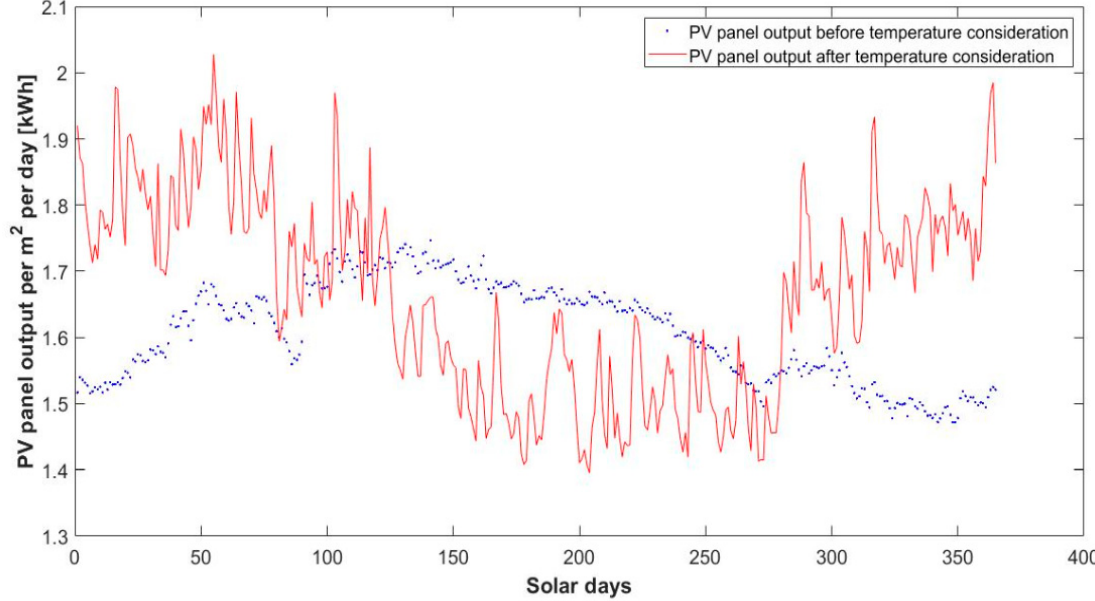
Figure 9. PV panel output considering the effect of temperature on output power.